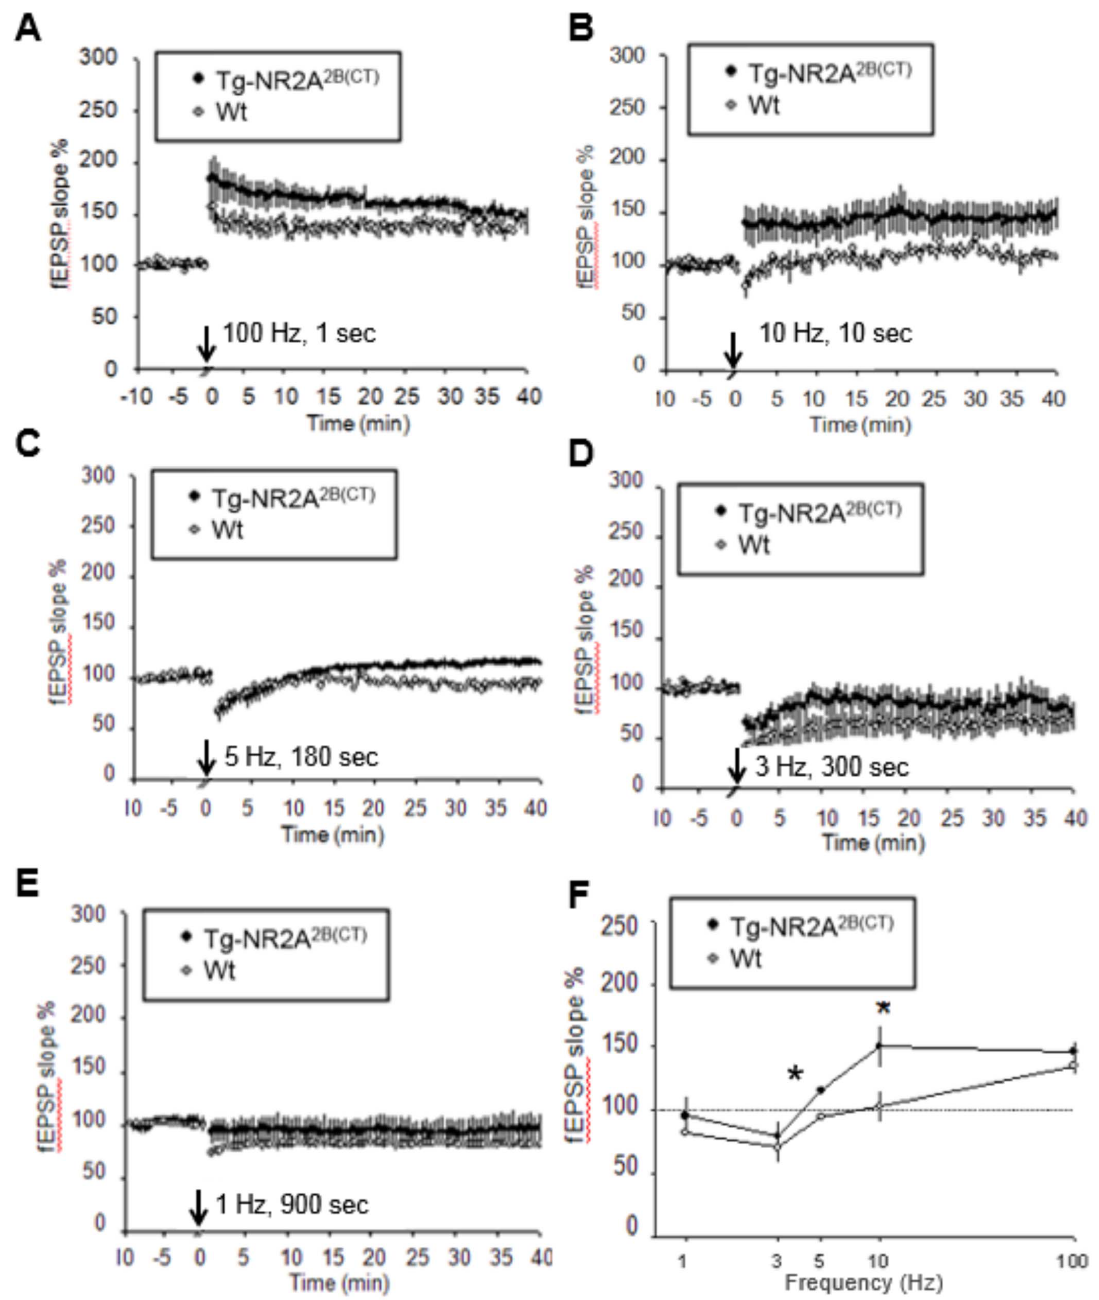
Figure 4. Enhanced LTP in the Tg-GluN2A 2B(CT) mouse hippocampal slices. A. Slightly enhanced LTP seen in the Tg-GluN2A 2B(CT) mice with a 1 s 100 Hz stimulation. B. Significantly enhanced LTP was seen in the Tg-GluN2A 2B(CT) mice when a 10 Hz stimulation was applied from 10 s. C–E. No changes in LTD were seen in the 5 Hz, 3 Hz, or 1 Hz stimulation protocols. F. A summary plot of the % change in fEPSP slope versus the frequencies.